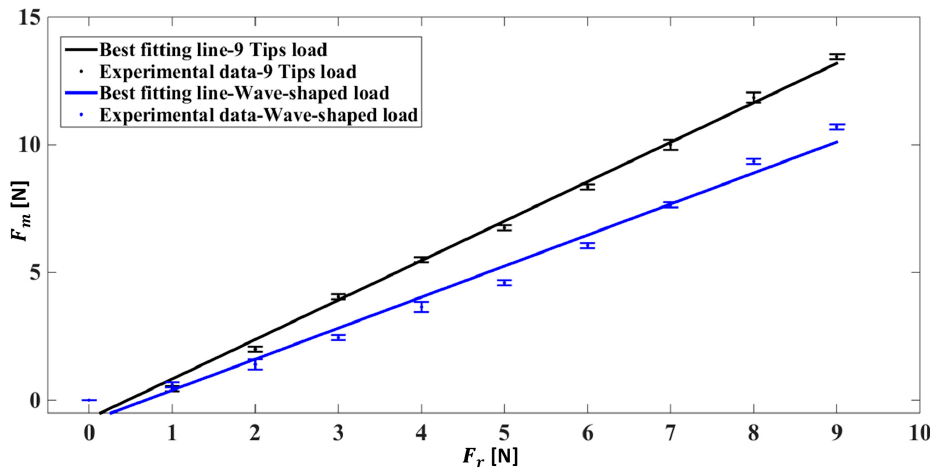
Figure 8. Mean value of force measured ± expanded uncertainty, for the sensor S2004–060 under human-like grasping conditions and each reference load applied. The best fitting line for each examined loading condition is also shown.